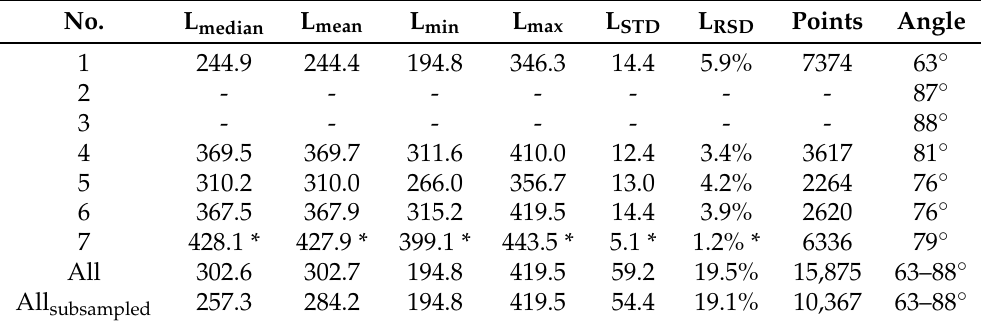
Table 10. The horizontal sample area: median luminance, Gaussian mean luminance, minimum luminance, maximum luminance, standard deviation, relative standard deviation, number of points, and angle between the surface normal and the measurement direction. Scans 2 and 3 were left with no observations due to the large measurement angle.